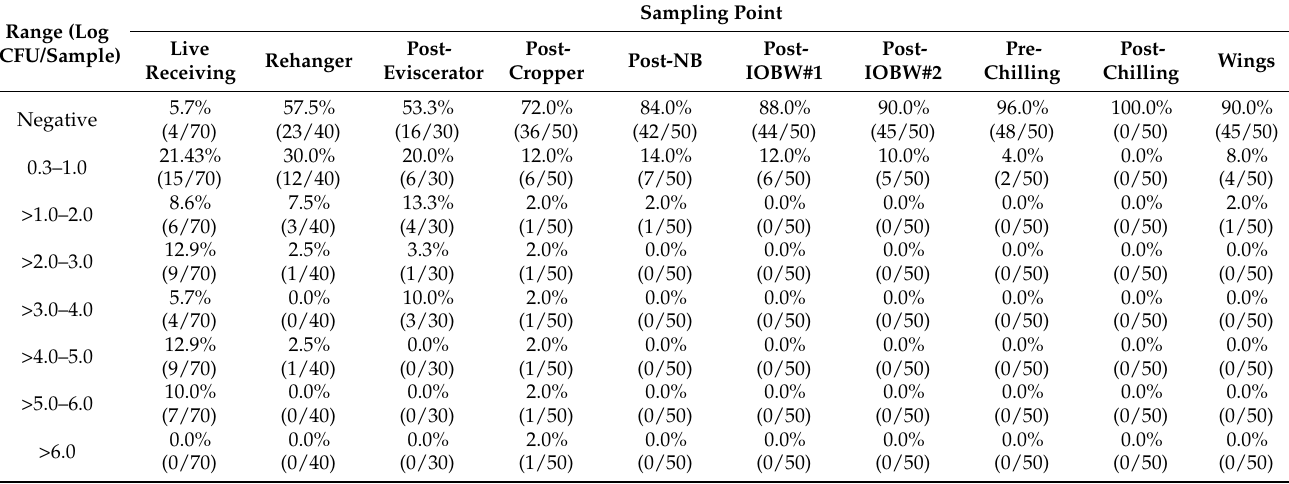
Table A5. Distribution of Salmonella counts (Log CFU/sample) on each of the ten sampling locations under normal process intervention on chicken and part rinses (n = 490 samples).